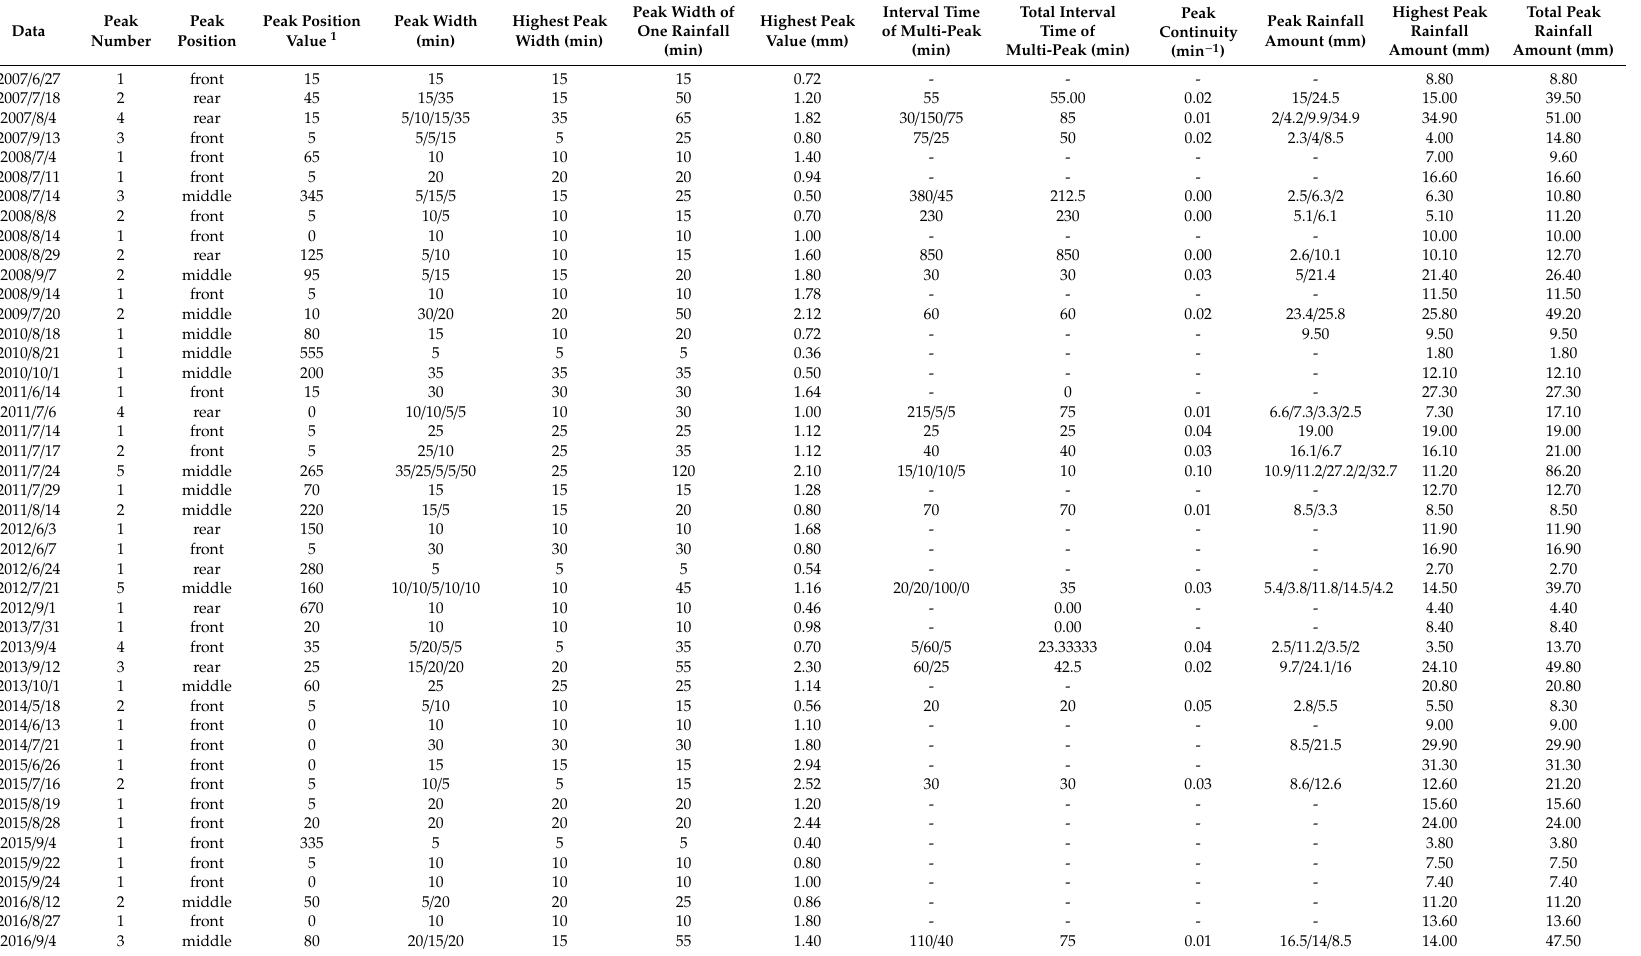
Table A2. The data set of morphological characteristics of rainfall